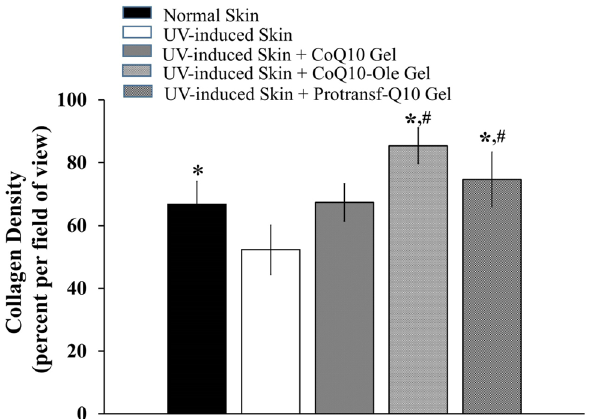
Figure 6. The collagen density of dermis layer of subject’s back skin without and with UV-induced photoageing after topically applied with saline (Normal skin and UV-induced skin), CoQ10-loaded Emulgel, CoQ10 dissolved in oleic acid (CoQ10-Ole) Emulgel, and protransfesomal CoQ10 (Protransf-CoQ10) Emulgel once every 2 days for 2 weeks. * P < 0.05 compared to UV-induced skin, # P < 0.05 compared to Normal Skin.